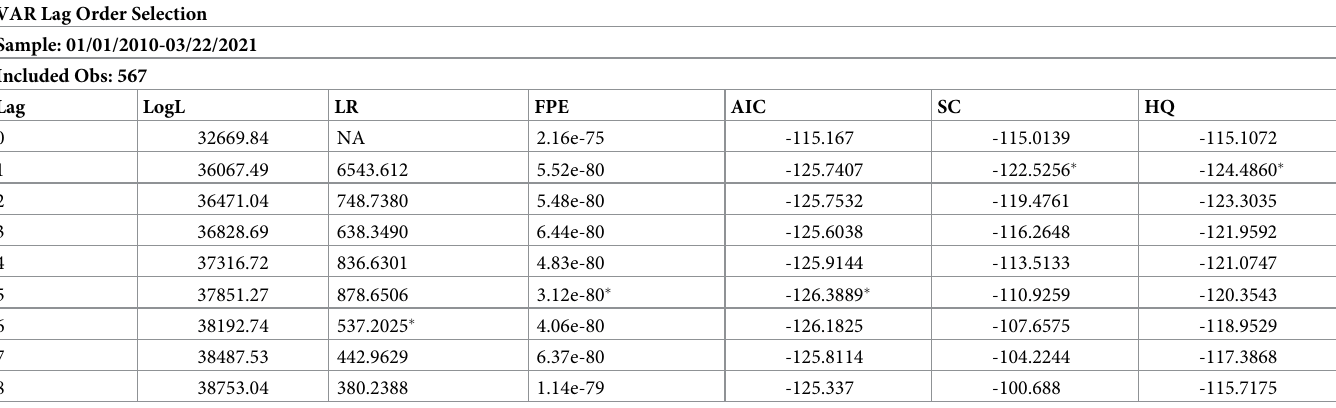
Table 5. VAR optimal lag selection. This table presents our VAR model optimal lag selection criteria. We mixed both illiquidity and volatility into one VAR model and we use five tests for optimal lag selection. LR is the sequential modified LR test statistic (each test at 5% level); FPE is the Final prediction error; AIC is the Akaike informa- tion criterion; SC is Schwarz information criterion; HQ is Hannan-Quinn information criterion. � indicates the optimal section based on the corresponding lag selection criteria. The sample runs from January 1, 2010 to March 22, 2021. VAR Lag Order